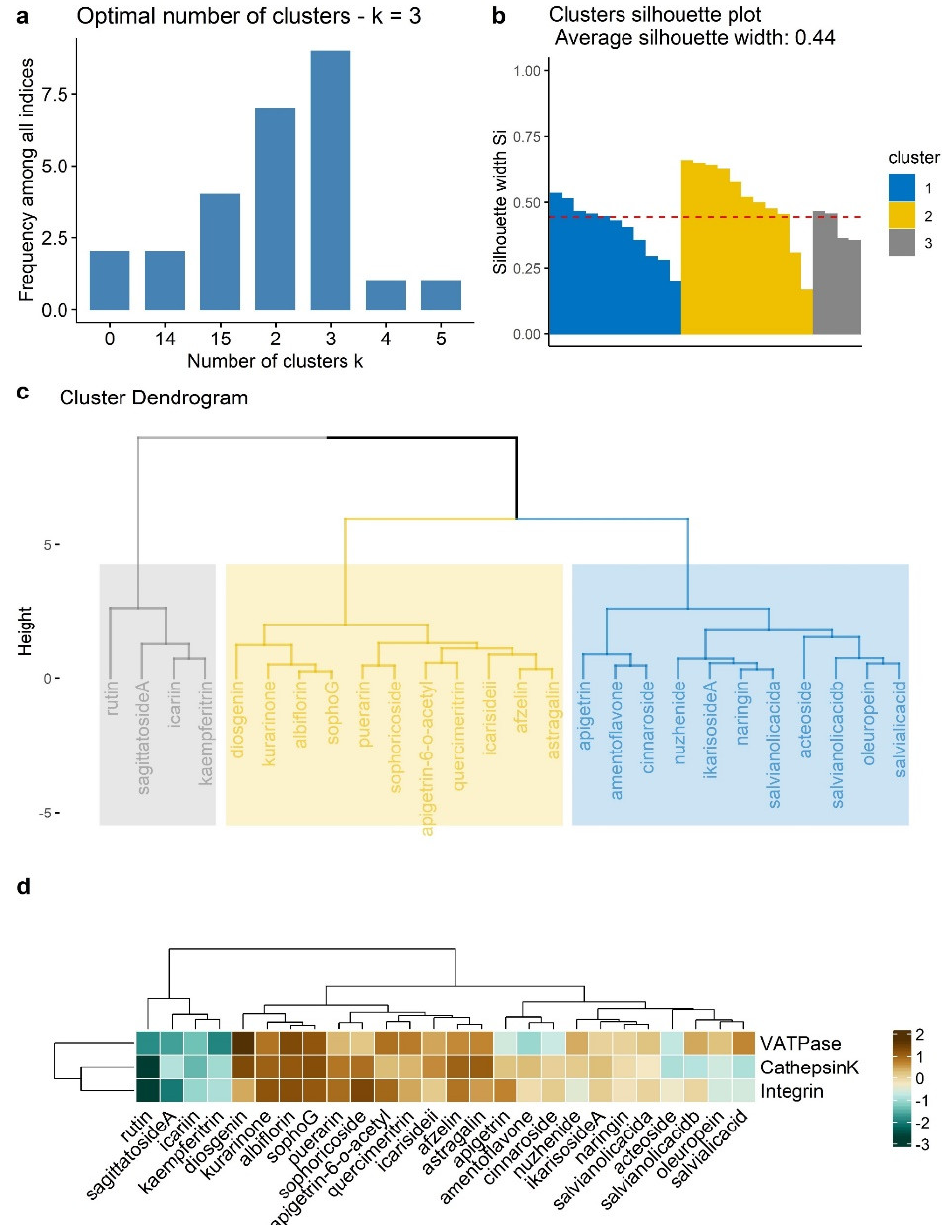
Figure 5. Subclustering analysis. The compounds in the selected cluster were subclustered using k-means and the hierarchical approach. ( a ) Proposed number of clusters, ( b ) cluster silhouette calculation for internal clustering validation, ( c ) cluster dendrogram, and ( d ) a heatmap clustering plot defined by color indicates the top 4 compounds.